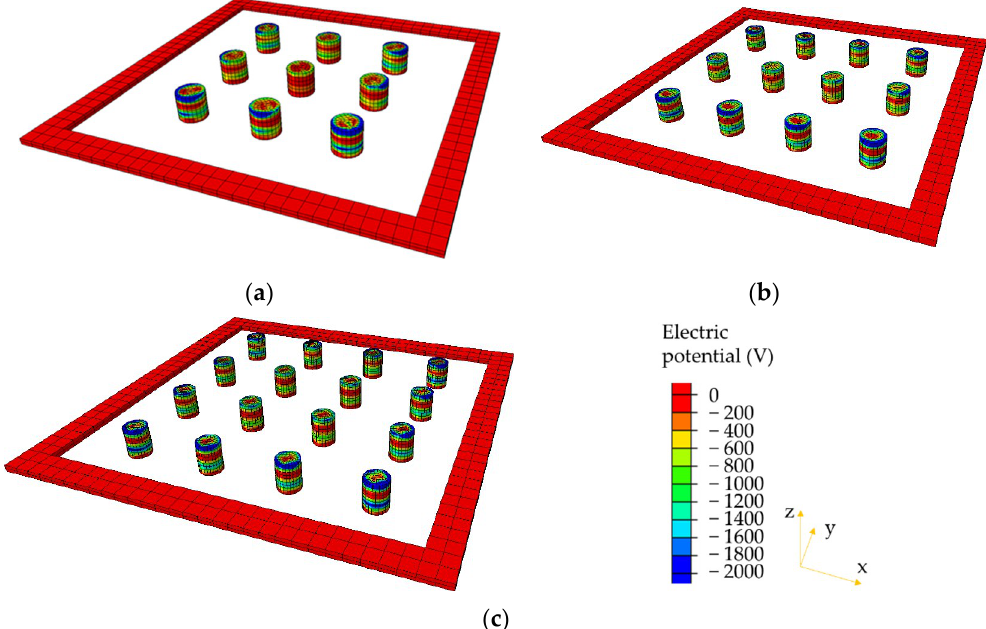
Figure 10. Electrical potential distributions in piezoelectric units under full loading condition: ( a ) 3 × 3 with diameter = 2 cm; ( b ) 3 × 4 with diameter = 1.73 cm; ( c ) 4 × 4 with diameter = 1.5 cm.